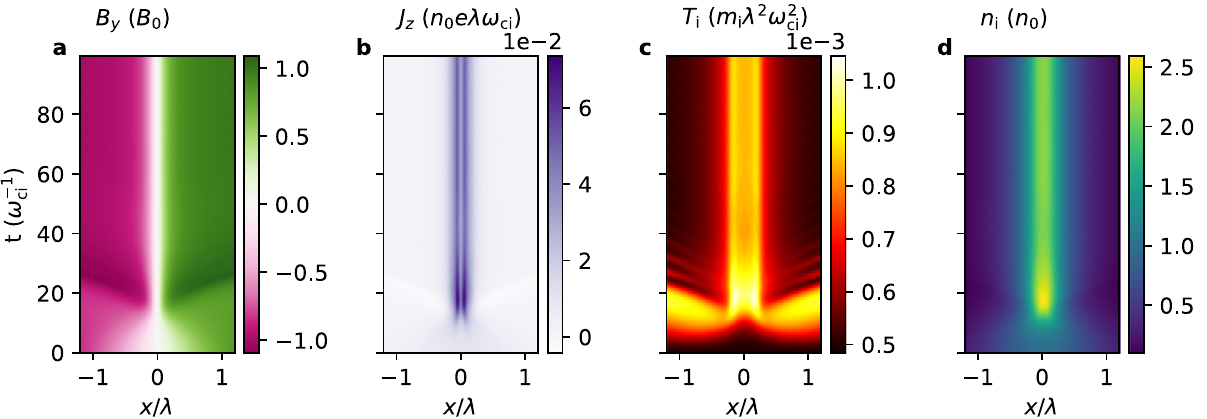
Fig. 3 Streak plots of variables from the particle-in-cell simulation. Streak plots of a the sheared magnetic fi eld B y , b the current density J z , c the ion temperature T i , and d the ion density n i from t = 0 to 100 ω (cid:2) 1 ci